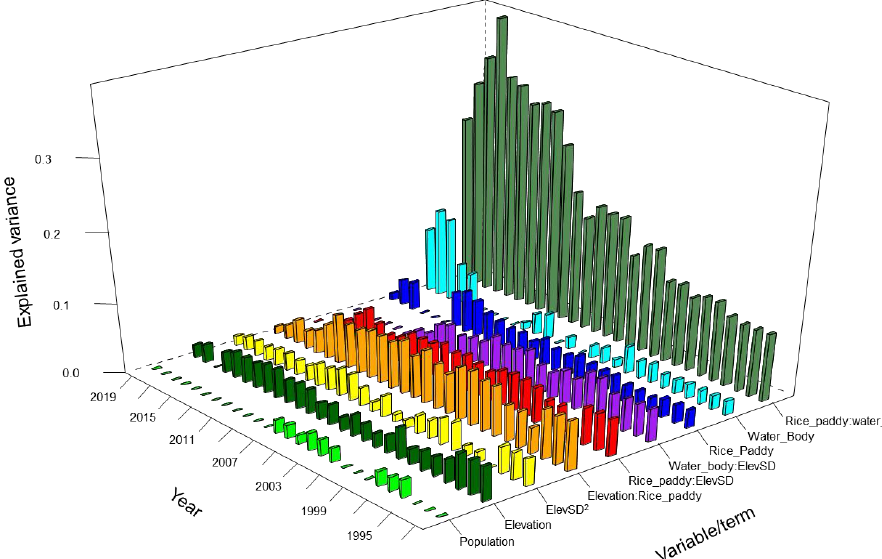
Figure 3. Contribution (proportion of explained variance) of variables/terms in the multiple regres- sions fitting the number of nests in the watersheds from 1993 to 2019. The growth of the crested ibis population was found to be density-dependent. In wa- tershed 723, the number of nests has been stable since 2005, and in watershed 717, the number of nests has reached carrying capacity since 2015. The population density in wa- tersheds 723 and 717 was 0.139 and 0.102 nests/km 2 , respectively. In contrast, the number